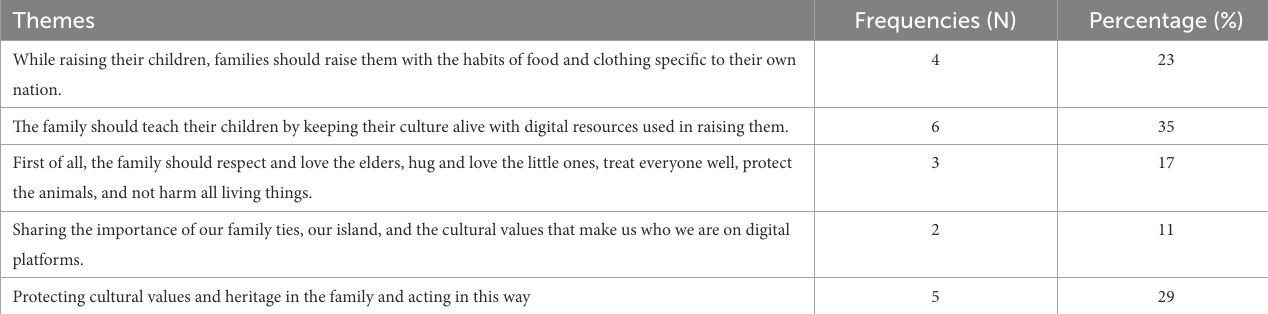
Themes Frequencies